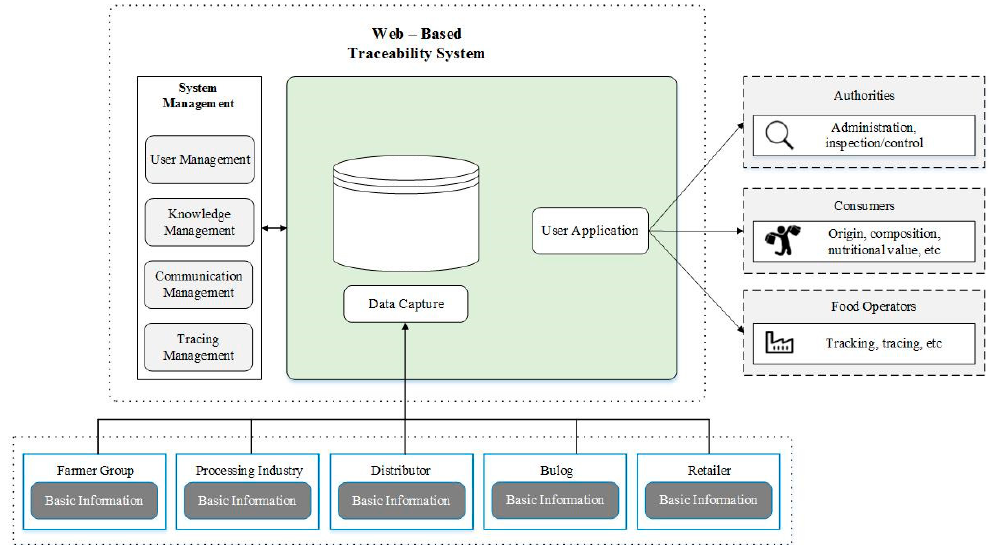
Figure 3. Traceability system architecture.